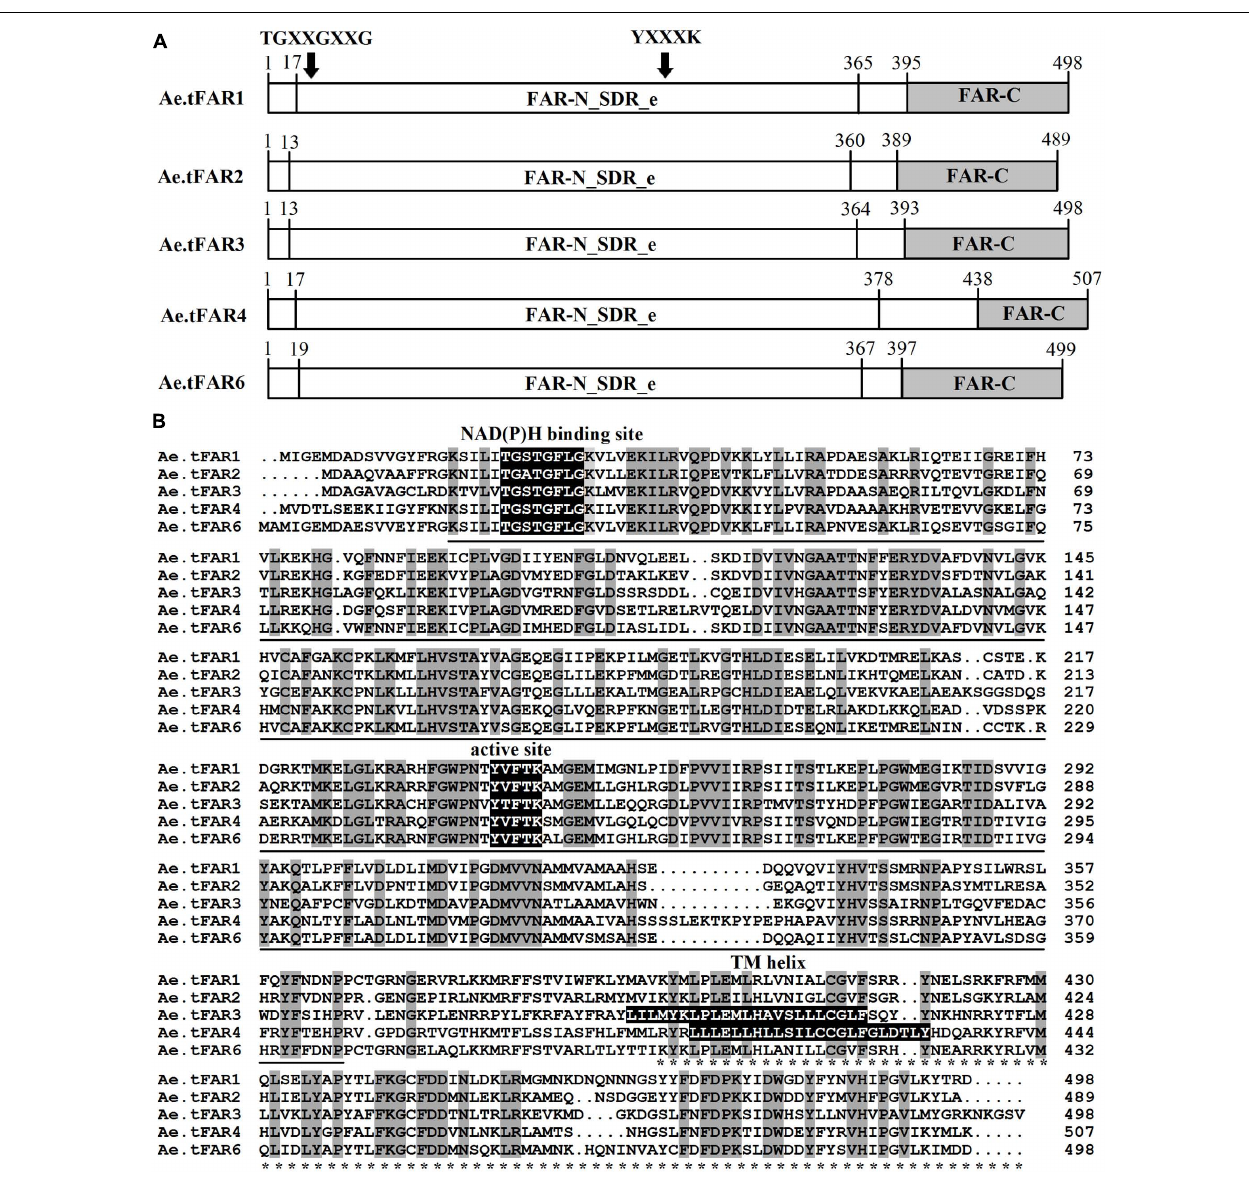
FIGURE 4 | The structure and functional domains of the five Ae.tFAR proteins and amino acid sequence alignment. (A) Predicted functional domains of Ae. tauschii FARs. The conserved FAR-N_SDR_e and FAR_C domains are marked by underline and asterisks, respectively. The numbers indicate amino acid positions. (B) Amino acid sequences of the five Ae.tFARs. Identical amino acids are highlighted in dark gray. Three conserved motifs, NAD(P)H binding site motif (TGXXGXXG), active site motif (YXXXK), and TM (transmembrane) helix motif are highlighted in black (where X represents any amino